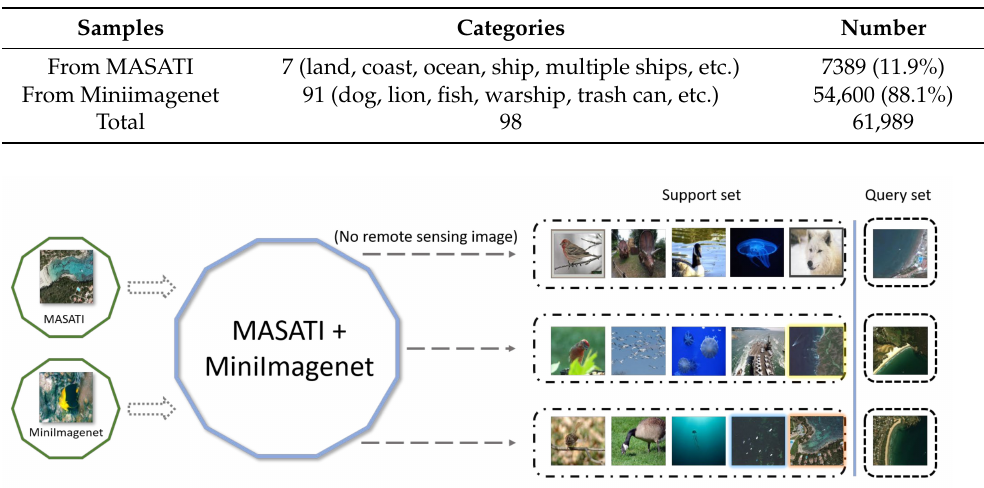
Figure 5. We use remote sensing image data in the MASATI and data in the Miniimagenet datasets to create a new dataset for training. The training set contains a small number of remote sensing image data. During meta-learning training, there may be only one or two of the five images sampled in the training set or even no remote sensing images. When testing the performance of the model, the unseen remote sensing images are used to evaluate the cross-data domain ability of the model